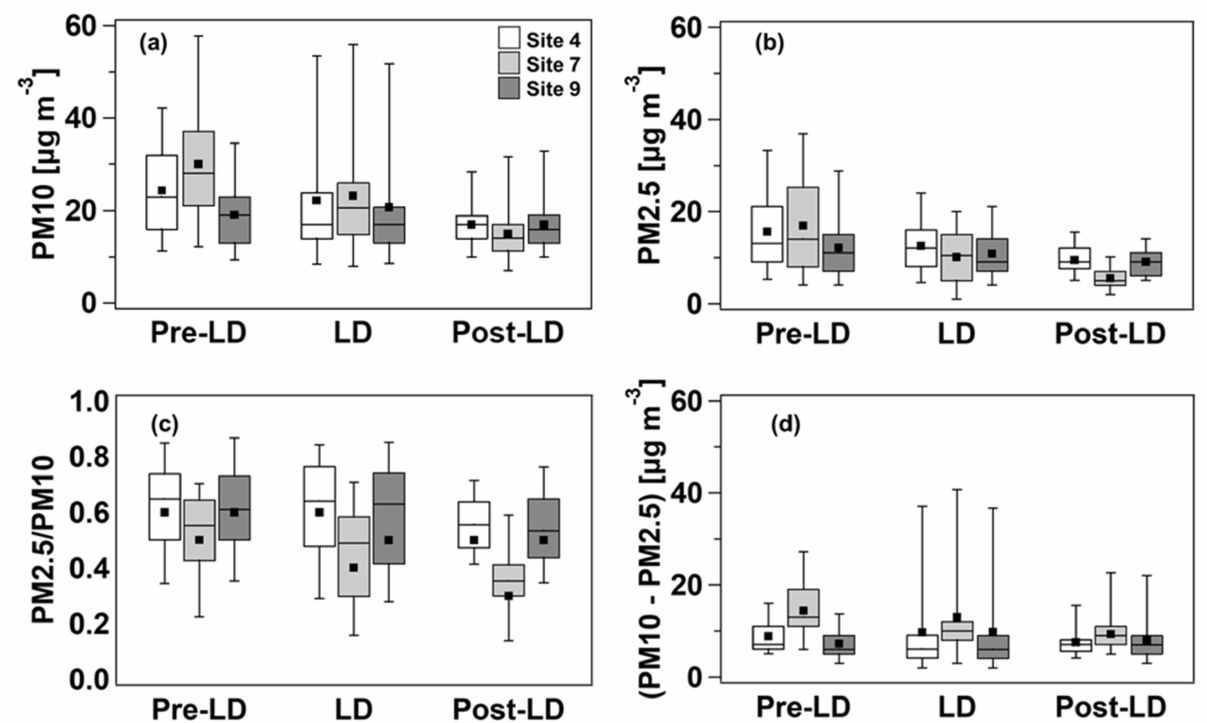
Figure 5. Box plots of ( a ) PM10 and ( b ) PM2.5 mass concentrations, ( c ) PM2.5/PM10 mass ratio, and ( d ) (PM10—PM2.5) mass concentrations of the Sites 4 (Lecce—Libertini, white box), 7 (Campi Salentina, light grey box), and 9 (Cerrate, dark grey box) in the Pre-LD (before lockdown), LD (during lockdown), and Post-LD (after lockdown) periods. Horizontal lines and dots in each box are the median and mean values, respectively. The 25th and the 75th percentiles are indicated by the lower and the upper boundaries of each box, respectively. The lower and upper whiskers represent the 5th and the 95th percentiles,